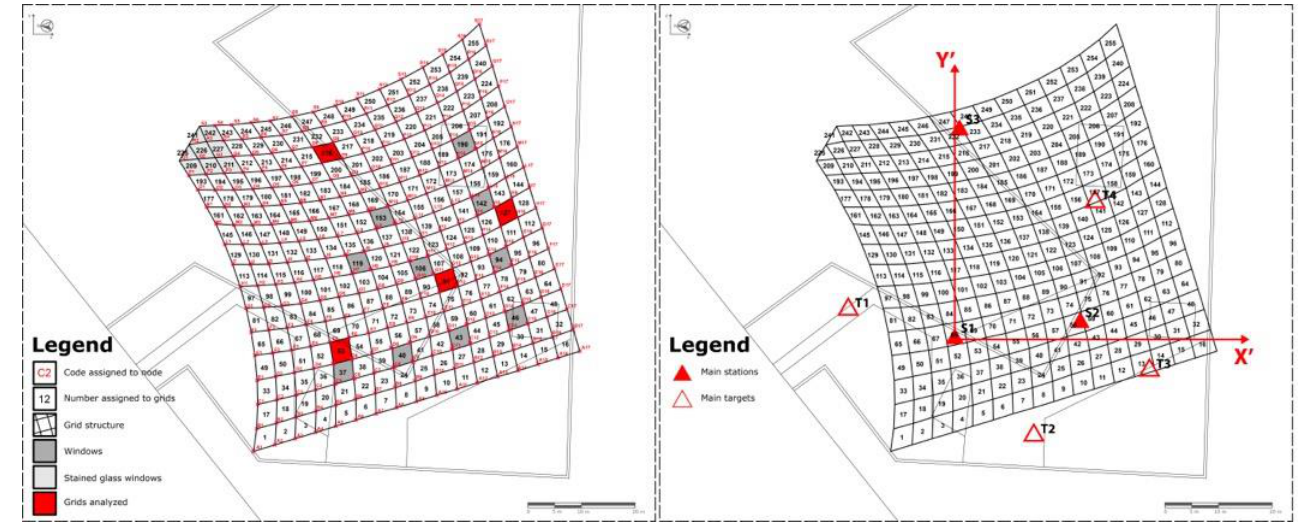
Figure 4. Schematic diagram of the structure with nodes and grids classification ( left image ), topo- graphic network, reference system, and GCP ( right image ).